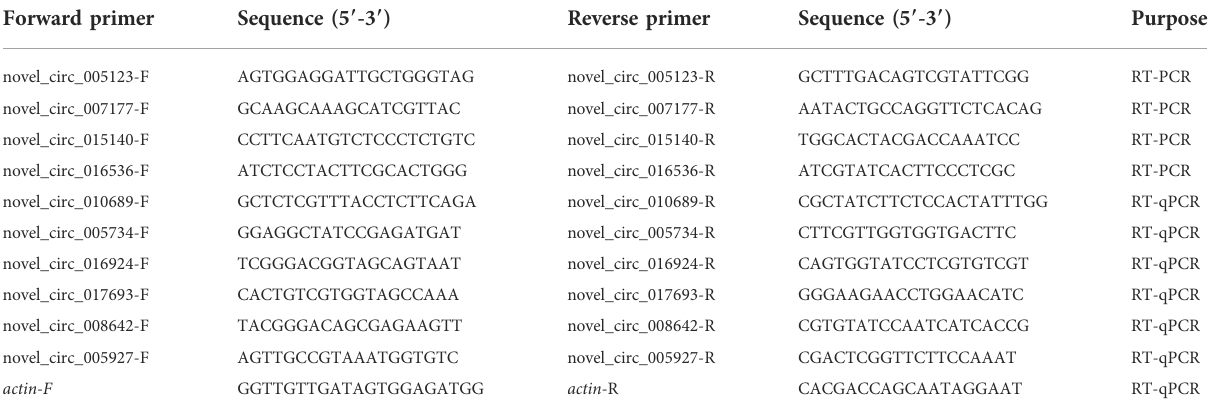
TABLE 1 Primers for RT-PCR and RT-qPCR conducted in this work. Forward